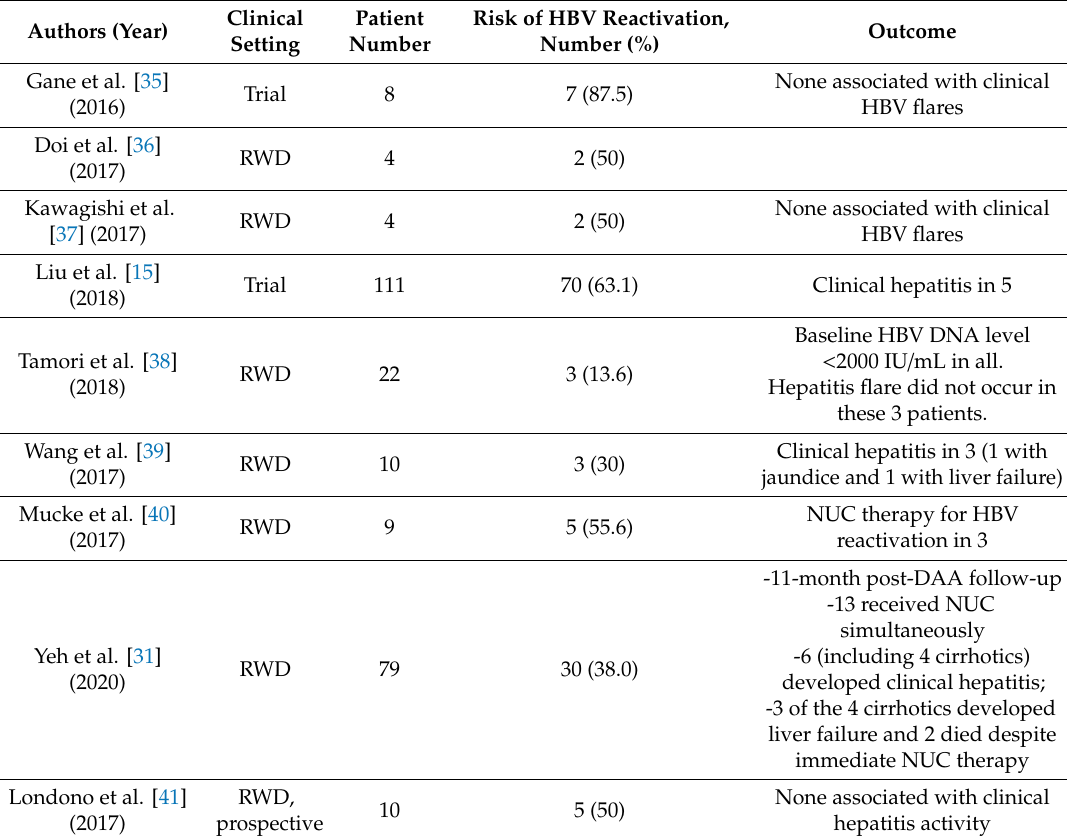
Table 1. Risk of hepatitis B virus (HBV) reactivation in hepatitis C virus (HCV) / HBV co-infected patients receiving direct-acting antiviral (DAA) therapy for chronic hepatitis